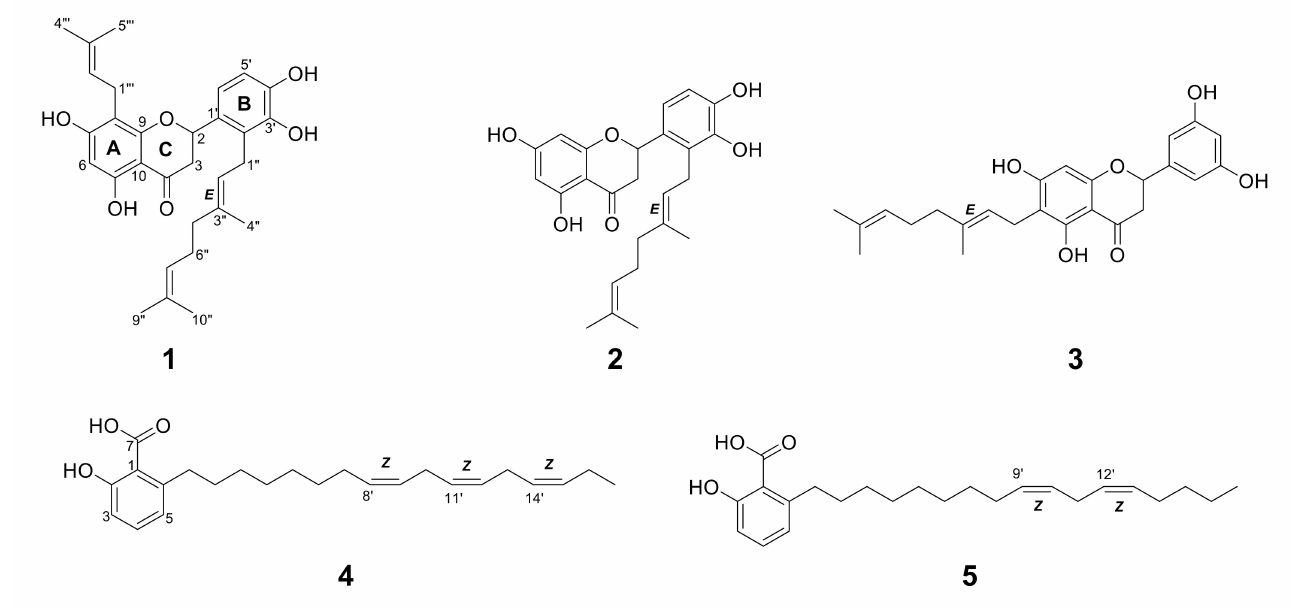
Figure 1. Structures of 1 – 3 from Macaranga tanarius and 4 – 5 from Syzygium jambos . Compound 1 was obtained as a light yellow amorphous solid. The 1 H NMR